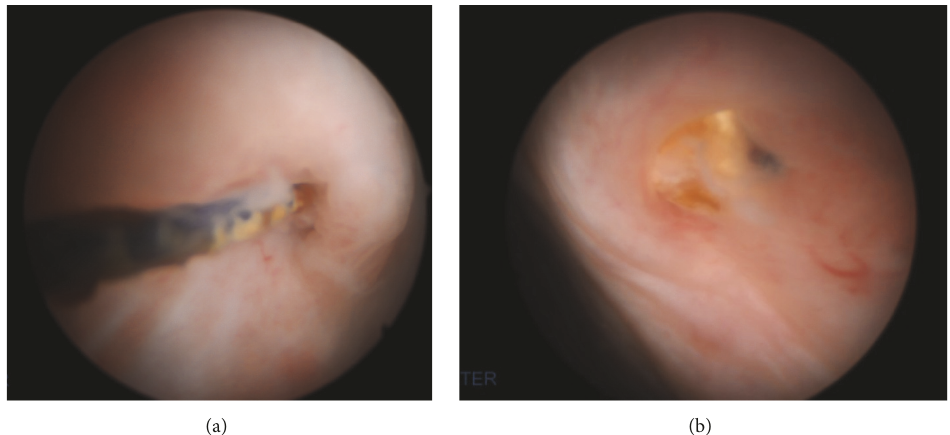
Figure 2: Cystoscopic images showing suture erosion at the right and left anterior bladder wall just inferior to the